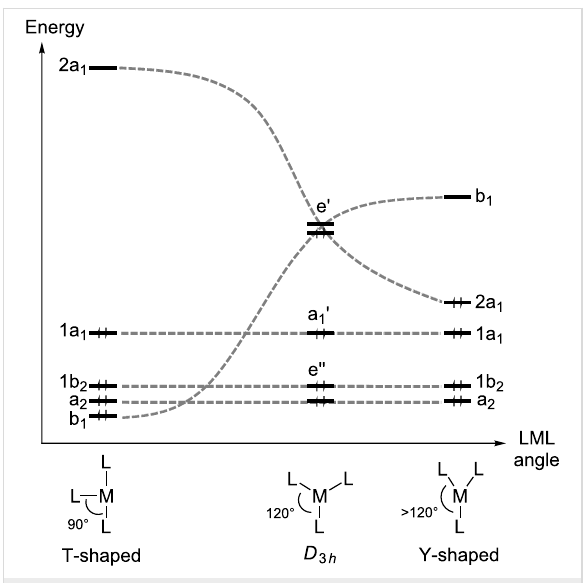
Figure 2: Walsh diagram for the d-block of a d 8 ML 3 complex upon bending of one L–M–L angle.